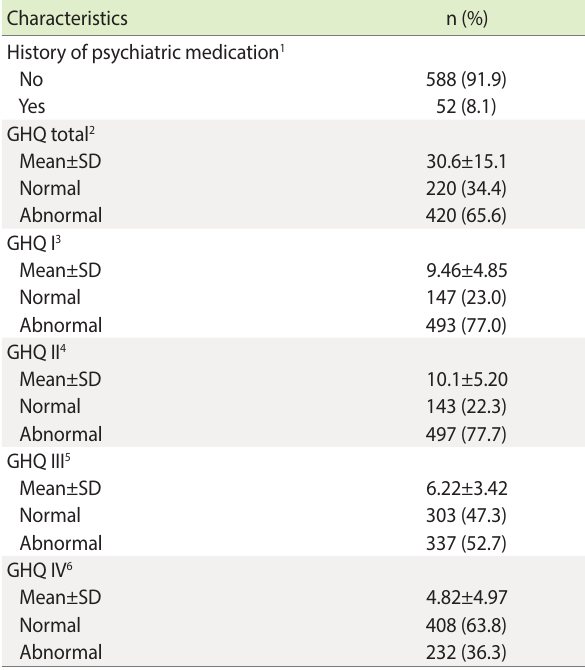
Table 2. Frequency distribution of mothers according to GHQ